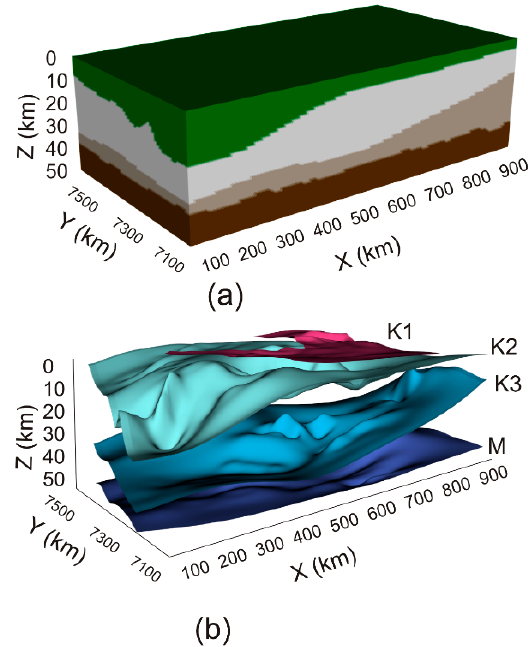
Figure 4. Three-dimensional model of the density distribution of the earth’s crust of the White Sea region ( a ) and spatial representation of the boundary surfaces K1, K2, K3, and M of the velocity layers of the region’s earth crust ( b ).